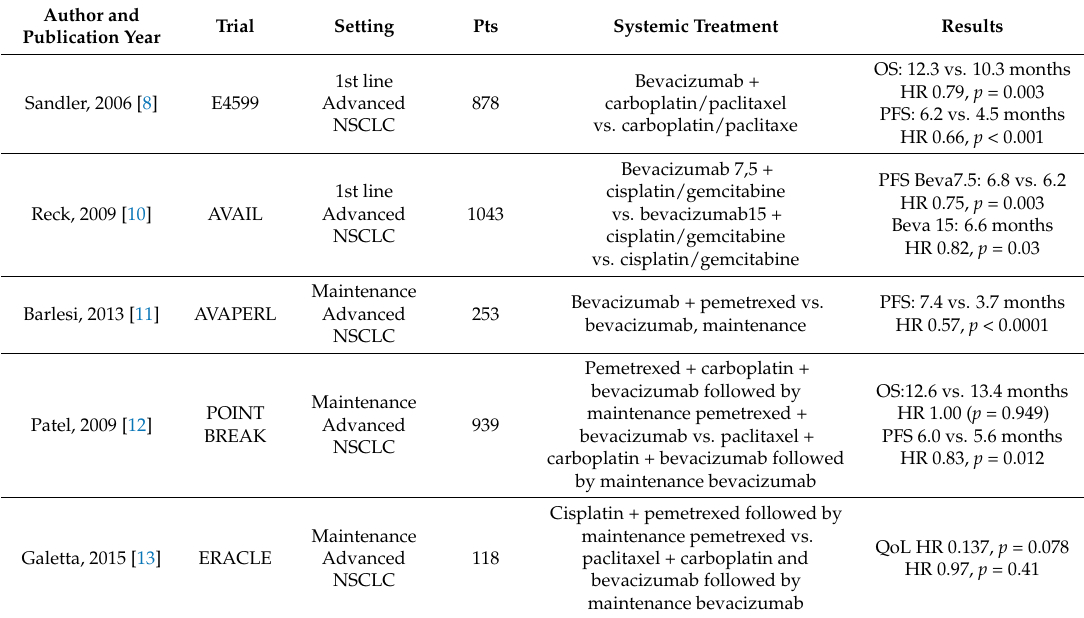
Table 1. Randomized phase III clinical studies with bevacizumab in